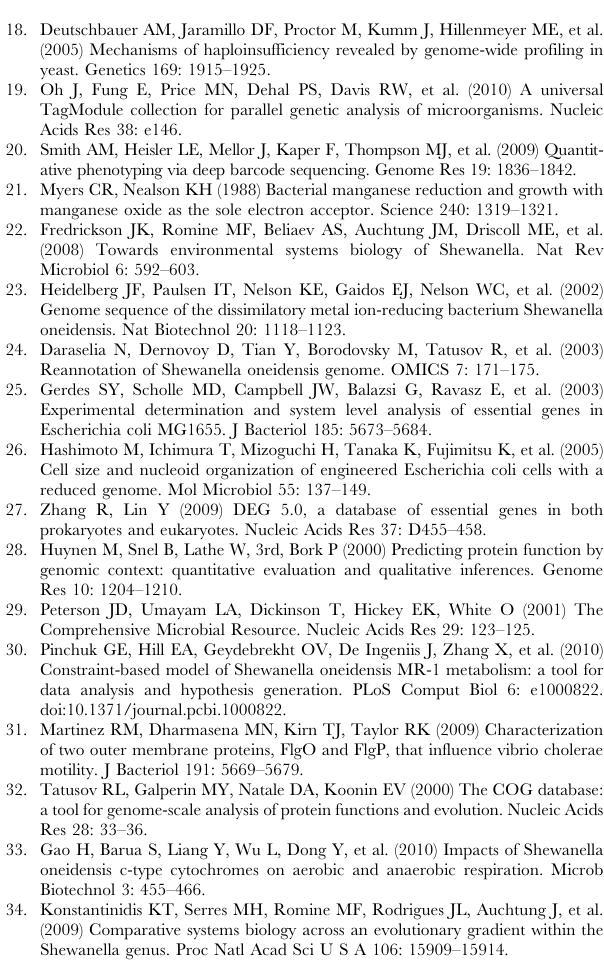
Table S1 List of S. oneidensis MR-1 transposon mutants. Table S2 S. oneidensis MR-1 essential gene classification. Table S3 List of conditions for pooled fitness experiments. Table S4 List of strains used in this study. Table S5 Strain fitness values 195 MR-1 fitness experiments. Table S6 Gene fitness values for 195 MR-1 fitness experiments.